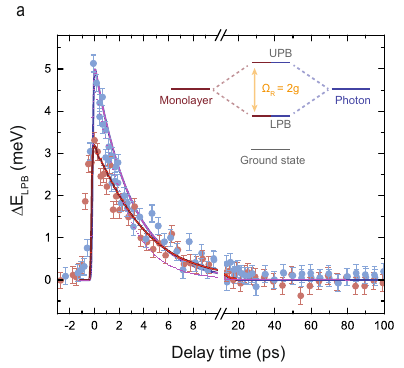
Fig. 4 | Comparison of the temporal dynamics for the ML microcavity and superlattice-N3. a LPB blueshift as a function of the time delay for low (red) and high (blue) pumping power. The dots represent the experimental points while the solid linesarethe fi tconsideringthemodelreportedinthemaintext,whichshows asingleexponentialdecay.Inset:schematicillustrationofthepolaritoneigenstates inthesingleMLmicrocavity,whichconsistoftwobrightpolaritonmodes(UPBand LPB)separated bythe Rabienergy, Ω R =2g. b Same asin a butforthesuperlattice-